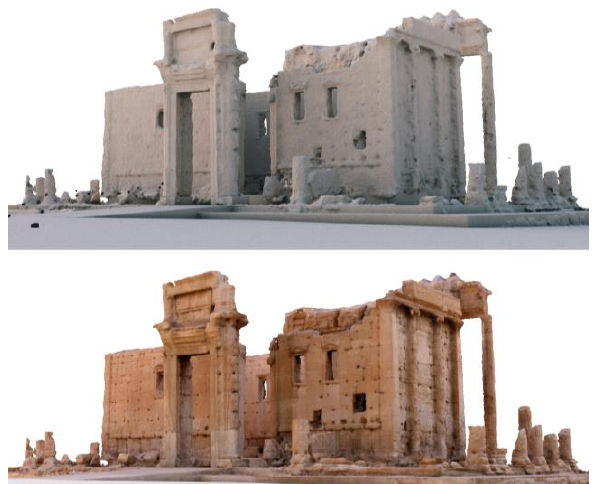
Figure 13: The final 3d model of Bel Temple shown as mesh of the merged point cloud (top) and textured using scource photos